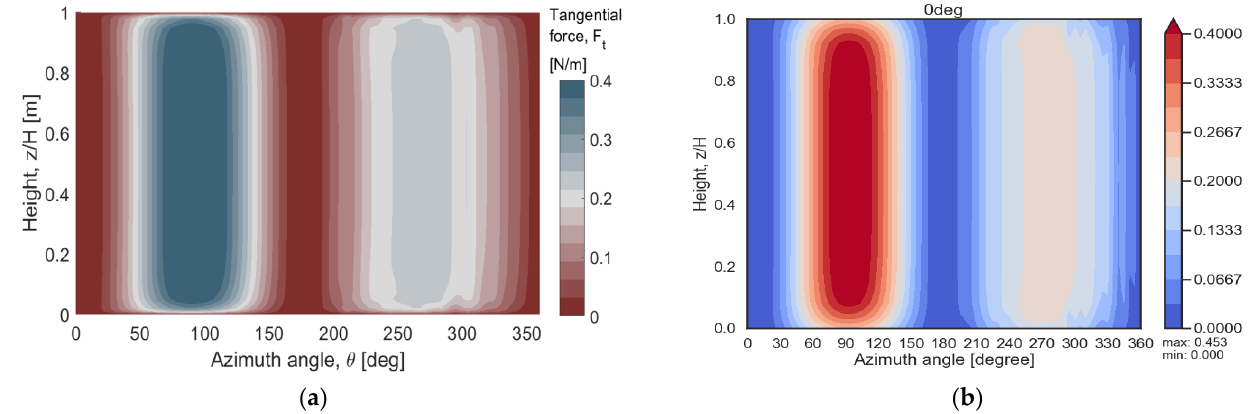
Figure 4. Contour graph of tangential blade force: ( a ) CACTUS, fixed-wake [30]; ( b ) this study (QBlade).